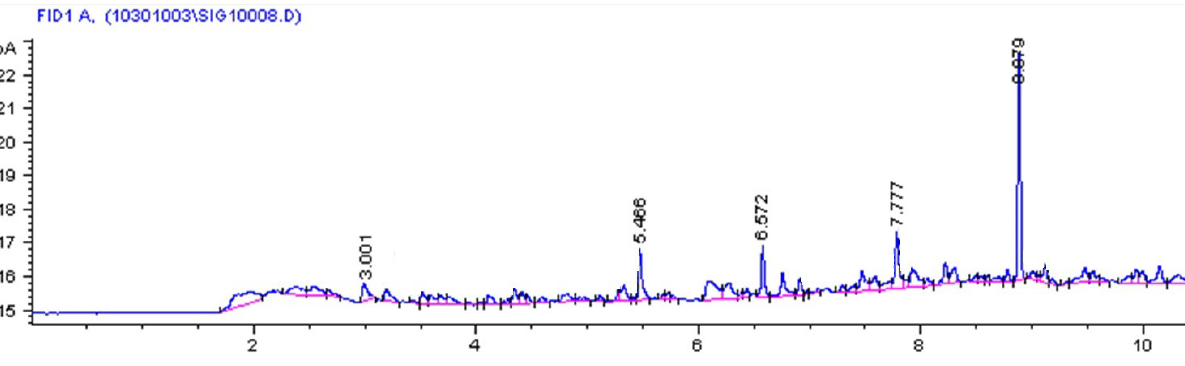
Figure 4. Typical gas chromatograph diagram of incense coil combustion using needle trap sampler. The sequence of retention times (min) respectively indicates the main by-products methanol, ethylbenzene, chloromethane, dichloromethane and